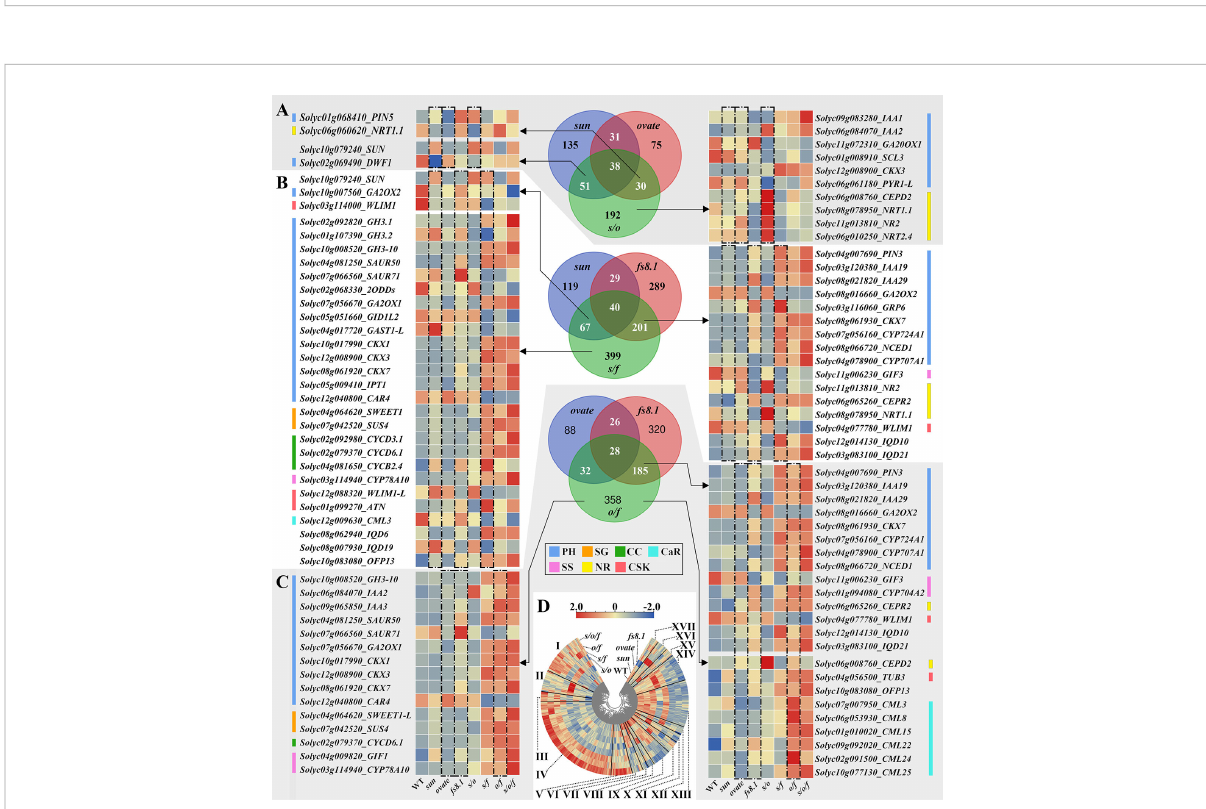
FIGURE 6 Venn diagram analyses of fruit shape NILs and the integrated expression patterns of the interested DEGs. (A) Venn diagram of sun , ovate and s/o NILs. (B) Venn diagram of sun , fs8.1 and s/f NILs. (C) Venn diagram of ovate , fs8.1 and o/f NILs. (D) Expression clustering of all the DEGs in fruit shape NILs. PH, plant hormone-related genes; SG, sugar-related genes; CC, cyclin; CaR, calcium-related genes; SS, seed size-related genes; NR, nitrate-related genes; CSK, cytoskeleton-related genes.